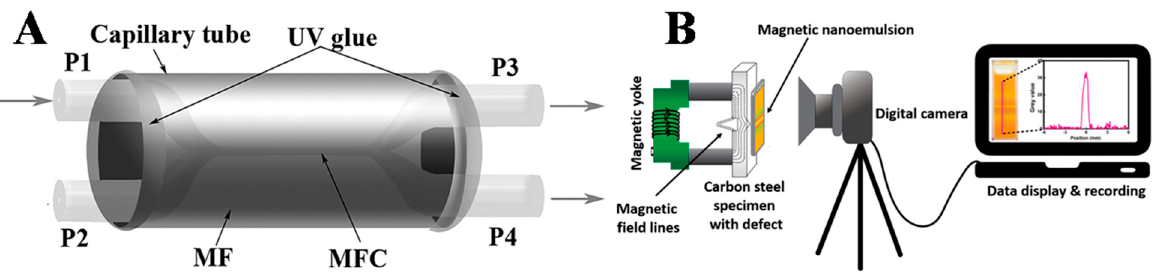
Figure 7. ( A ) Schematic of an MFC − based magnetic field sensor with an MF environment. Reprinted with permission from Ref. [78]. Copyright 2015, AIP Publishing; ( B ) schematic representation of the experimental setup for defect detection using MNE. Reprinted with permission from Ref. [81]. Copyright 2020, Elsevier.